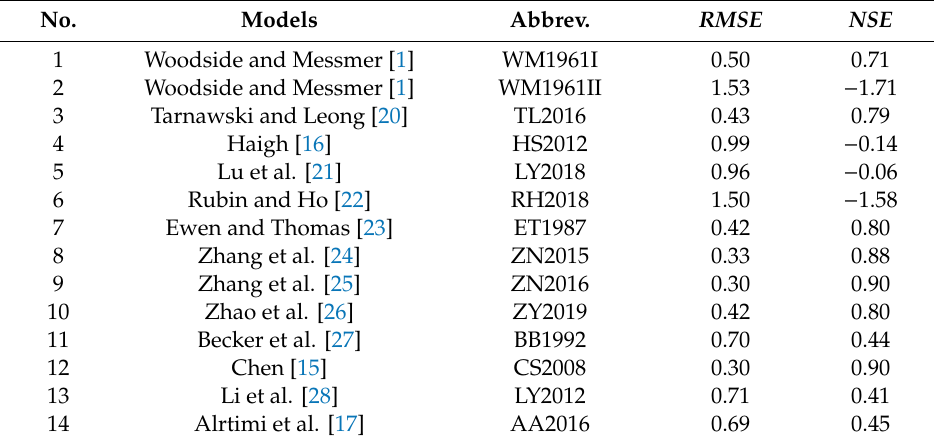
Table 2. Performance metrics of the 14 thermal conductivity models for